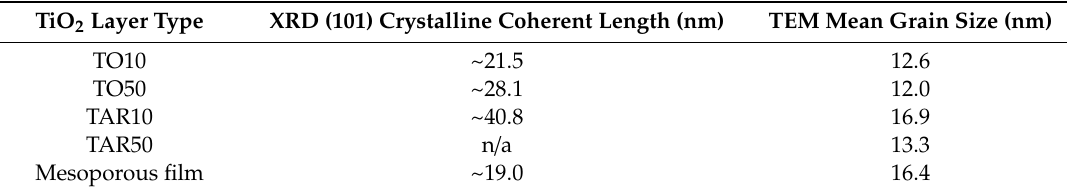
Table 2. Bu ff er layers: Structural and morphological features. Table 2. Buffer layers: Structural and morphological